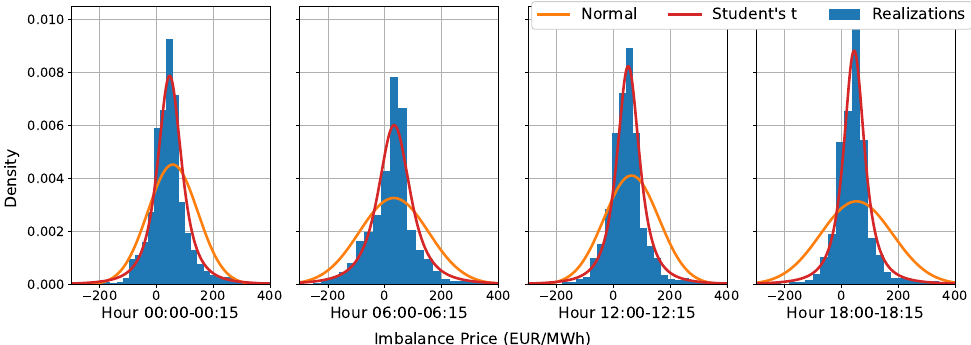
Figure 3. Histograms of imbalance prices with fitted densities for selected